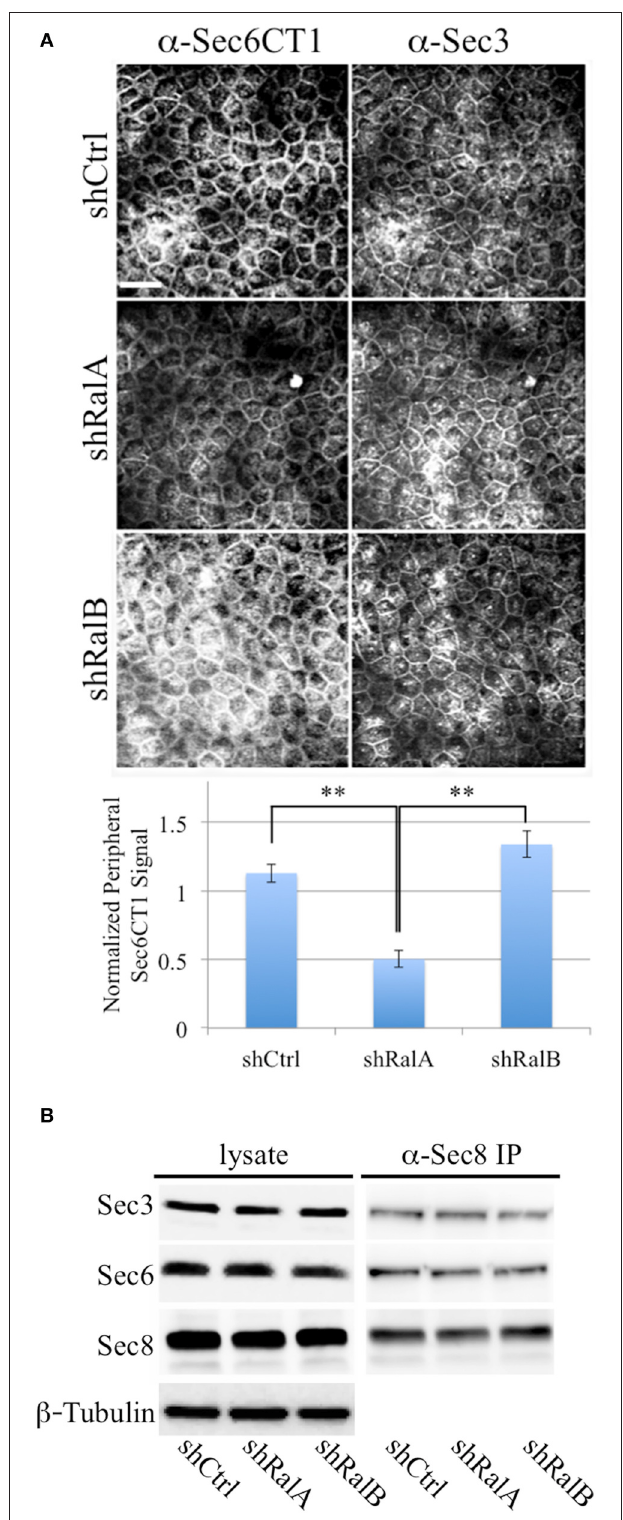
FIGURE 9 | RalA regulates plasma membrane exocyst configuration. (A) Accessibility of Sec6 CT1 epitopes is reduced when RalA, but not